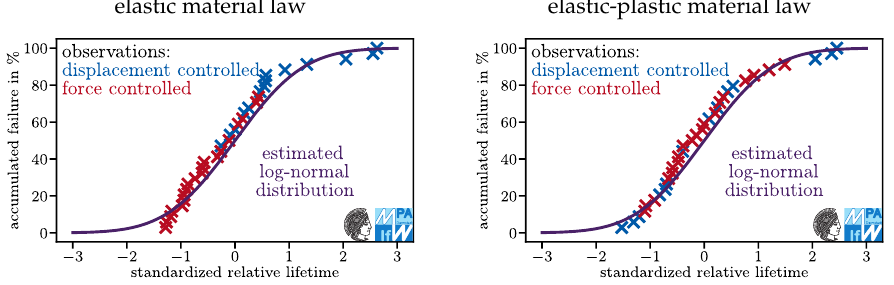
Figure A3. Estimated and observed accumulated failure rates for 50CrMo4 specimens in argon; 919MPa ultimate tensile strength; K t = 1.75.